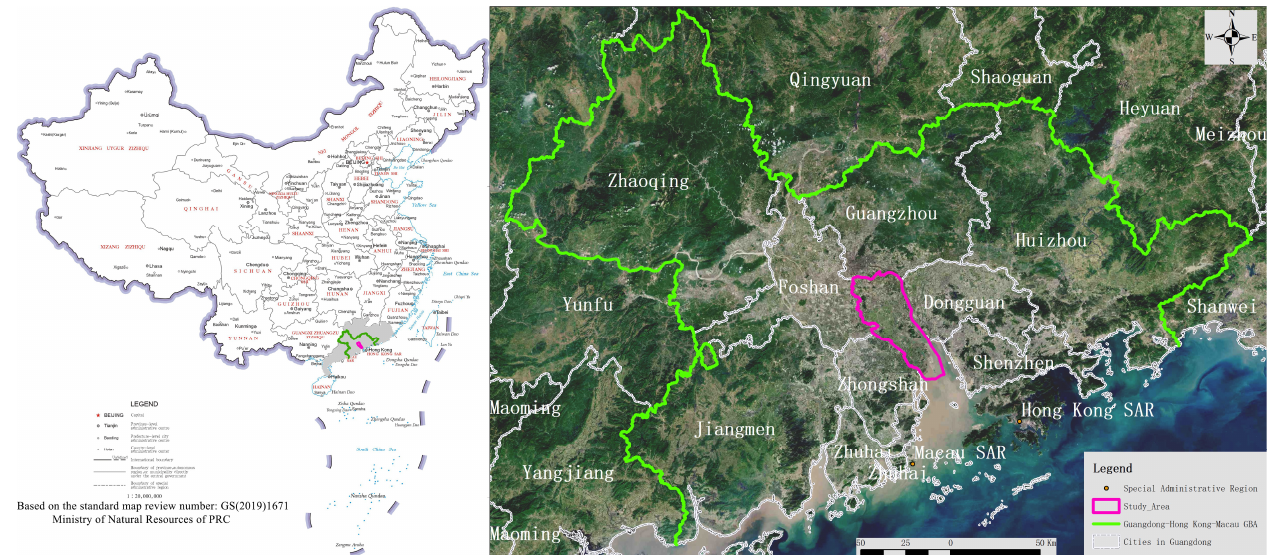
Figure 1. The location of the study area (the left map shows the Guangdong Province and GHM Greater Bay Area locations in China, based on the standard map review number GS(2019)1671, which comes from http://bzdt.ch.mnr.gov.cn/, accessed on 30 November 2021; the right map shows the study area locations in the GHM Greater Bay Area, all the data layers come from NRIDB).